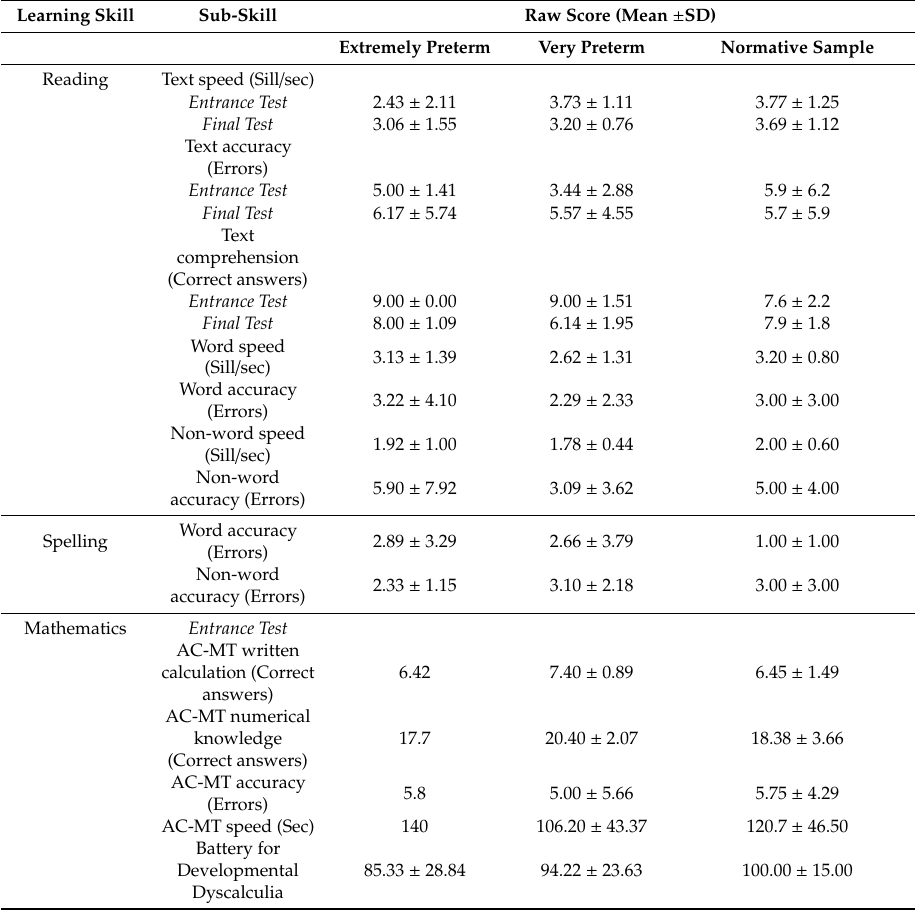
Table A3. Raw scores in learning skills in fifth grade